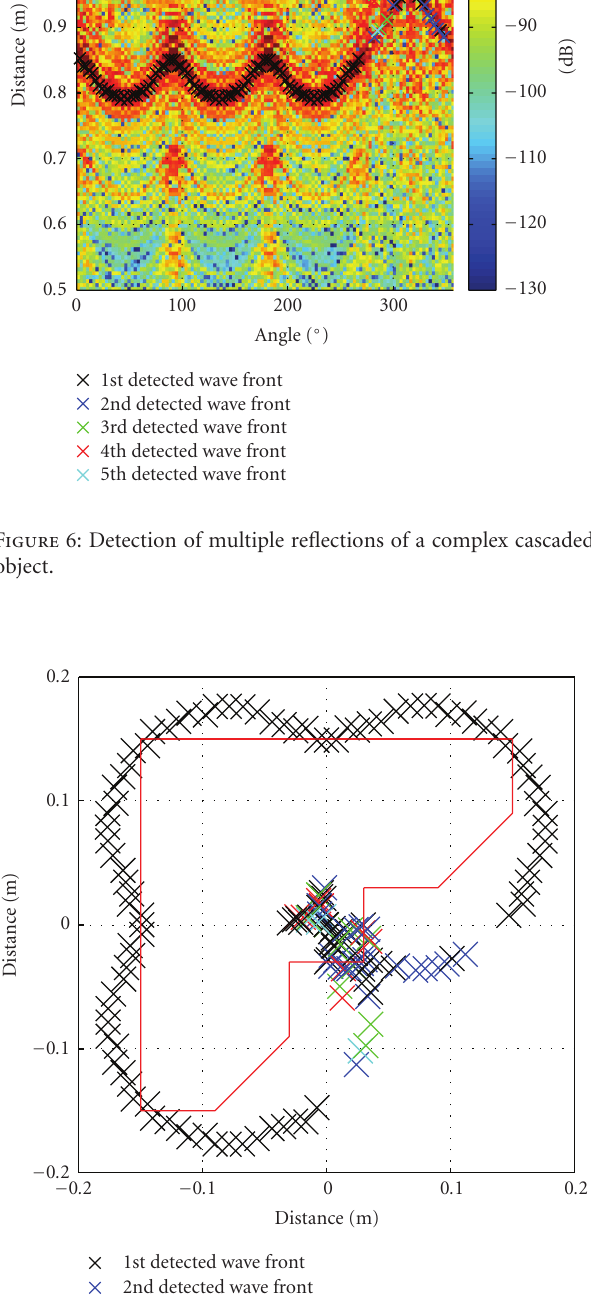
Figure 9: Measured radargram of a shifted rectangular object (30cm by 12